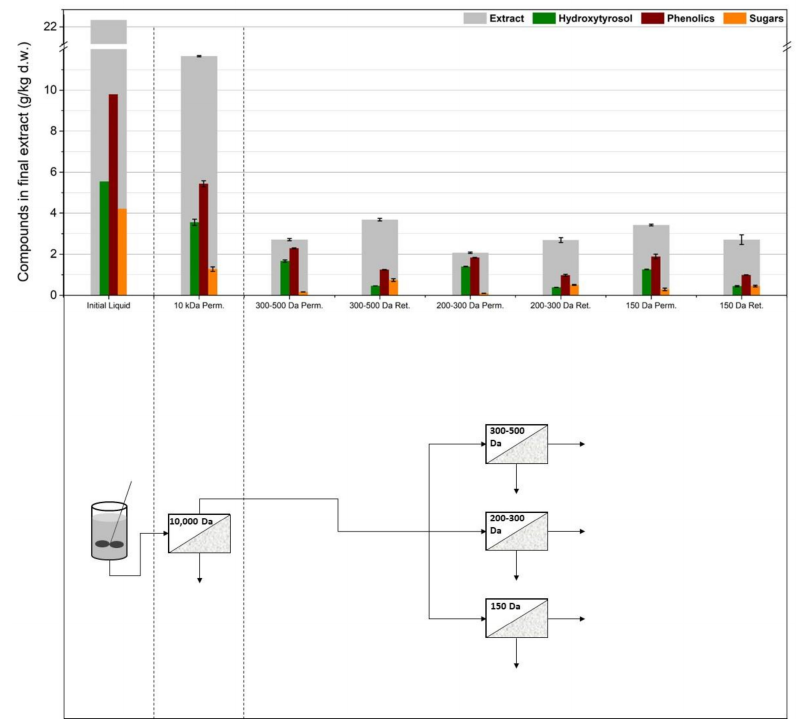
Figure 8. The third membrane treatment scheme: one ultrafiltration step (UP010) was used and the permeate from the 10,000 Da membrane was split into three equal parts and was treated with three different nanofiltration membranes (XN45, TS40,